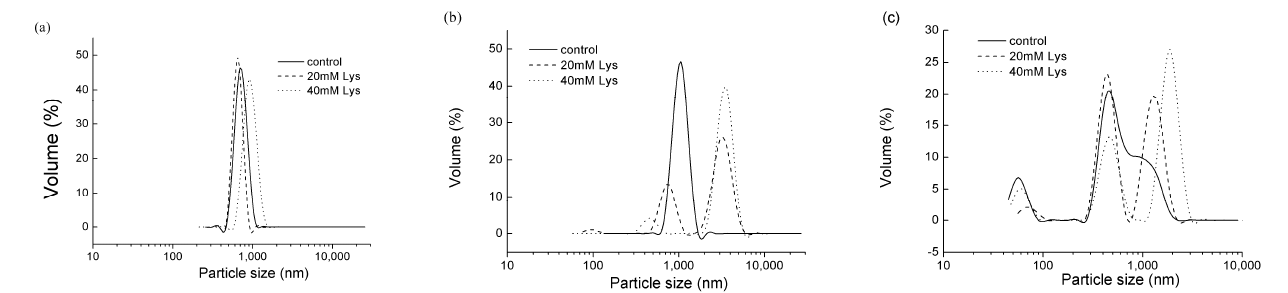
Figure 3. The effects of Lys on the particle size of MFP solutions at different ionic strengths. ( a ) The ionic strength of 0.15 M; ( b ) the ionic strength of 0.3 M; ( c ) the ionic strength of 0.6 M. Control, treatment without Lys addition; 20 mM Lys, treatment with 20 mM Lys; 40 mM Lys, treatment with 40 mM Lys.